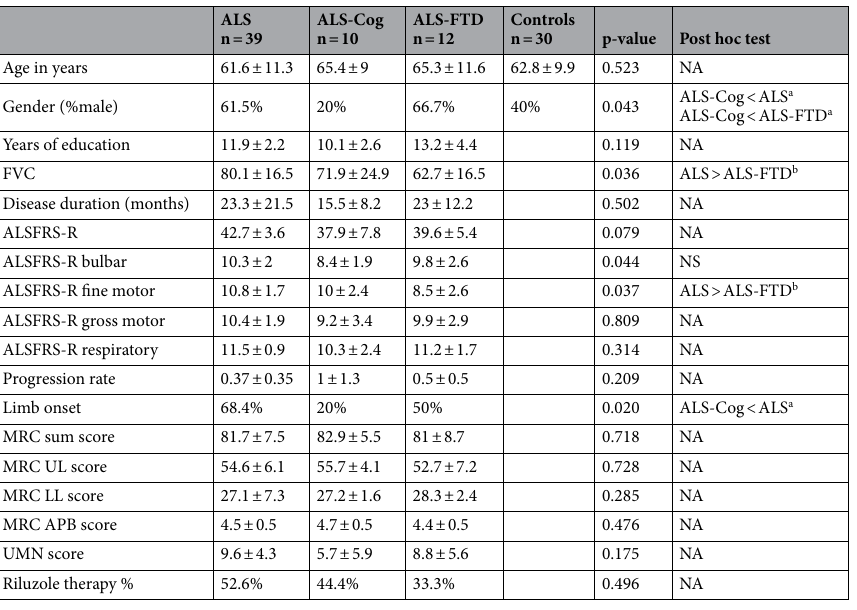
Table 1. Baseline characteristics. Table showing clinical features including motor features and functional scores on various subdomains of the Amyotrophic lateral sclerosis functioning rating scale—revised version (ALSFRS-R). ALS, amyotrophic lateral sclerosis; FTD, frontotemporal dementia; MRC score, Medical Research Council score; UMN score, upper motor neuron score; UL, upper limb; LL, lower limb; FVC, forced vital capacity; NA, not applicable. a 0.01 < p < 0.05; b 0.001 < p < 0.01; c p < 0.001, NA = not applicable, all mean variables presented as mean ±